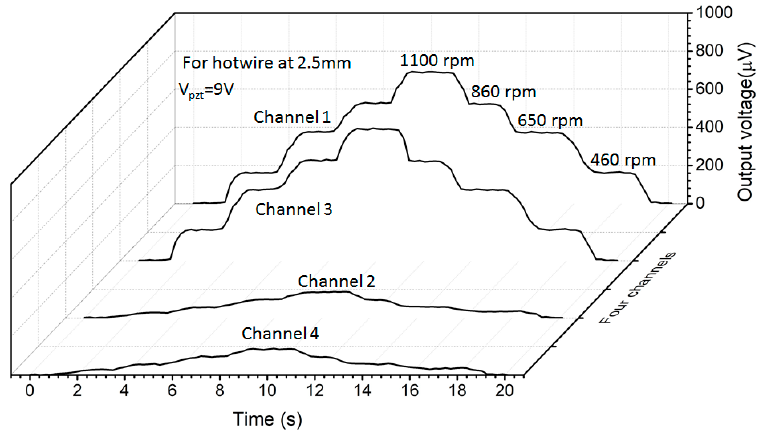
Figure 14. Time-resolved output from hotwires in four channels. The measurement was conducted with V PZT = 9 V and a resonant frequency of 5.1 kHz. The voltages are offset from their initial values before the turntable rotates.